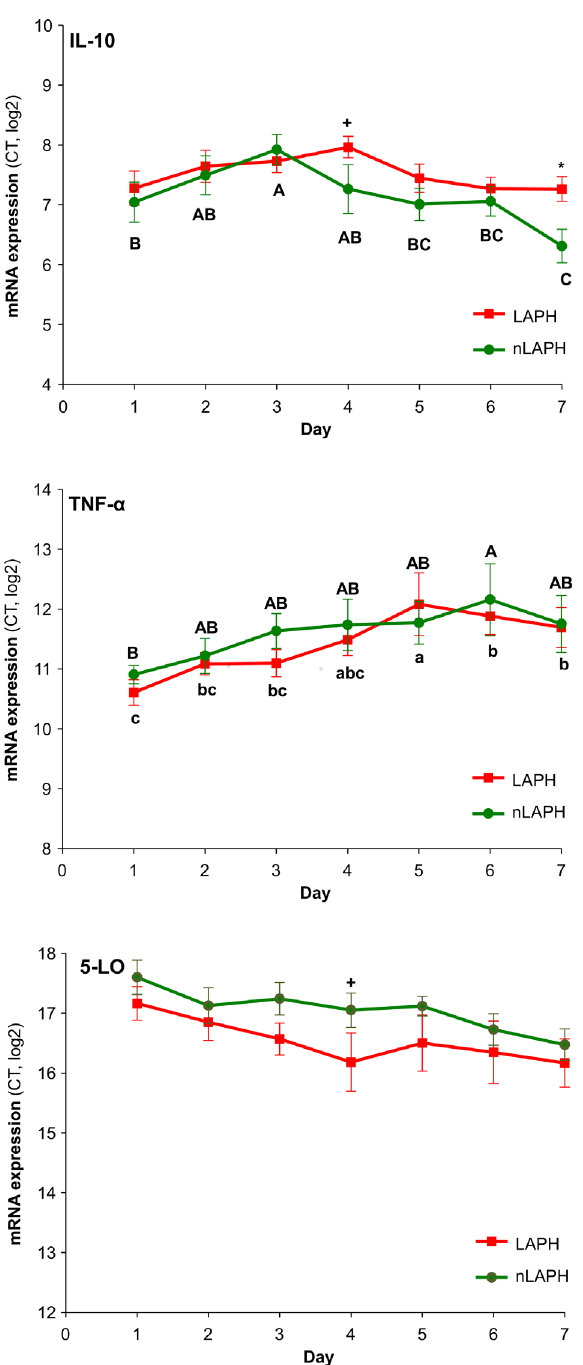
Fig 1. Time course of IL-10, TNF- α and 5-LO expression (mean ± SEM) in 24 survivor dogs with acute leptospirosis, including 13 dogs with (group LAPH) and 11 dogs without LAPH (group nLAPH). Differences between the disease groups LAPH and nLAPH are indicated as + ( P < 0.1) and * ( P < 0.05). Different letters indicate significant differences between the days (a,b,c for the LAPH group; A,B,C for the nLAPH group). Statistical significance. IL-10: disease effect P = 0.02, time effect P < 0.01, and interaction P = 0.42; TNF- α : disease effect P = 0.35, time effect P < 0.01, and interaction P = 0.94; 5-LO: disease effect P = 0.01, time effect P = 0.09, and interaction P =